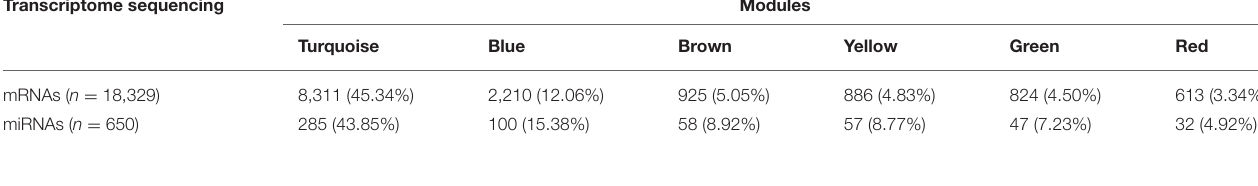
TABLE 2 | Summary of mRNA and miRNA module identifications.